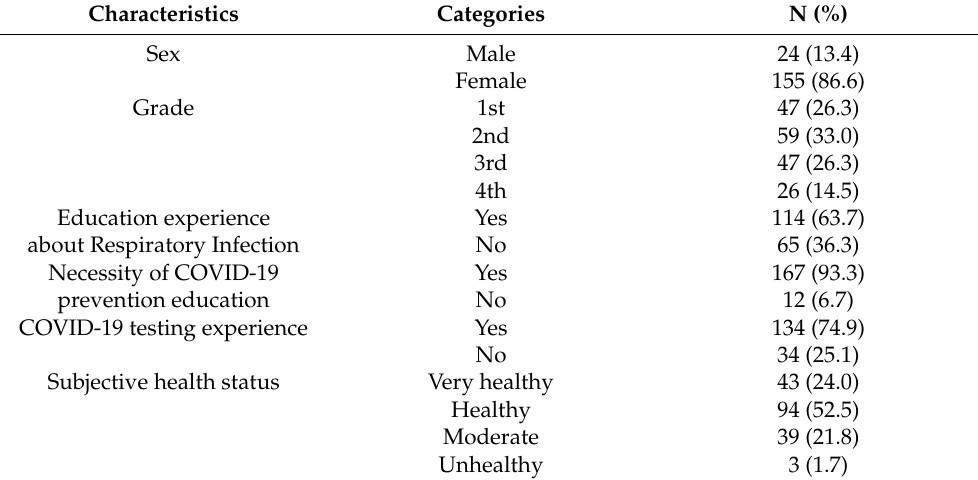
Table 1. General characteristics of